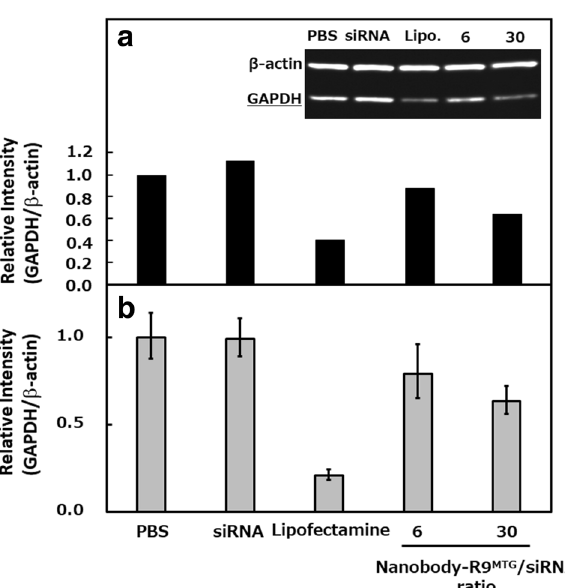
Figure 7. RNAi by Nanobody-R9 MTG –siRNA. ( a ) Western blot analysis of GAPDH in the A431 cell extract mixed with Nanobody-R9 MTG – siRNA using anti-GAPDH monoclonal antibody. ( b ) Real time PCR of the transcript in A431 cell extract mixed with Nanobody-R9 MTG – siRNA. Lipofectamine was used as a positive control. PBS phosphate buffered saline, Lipo lipofectamine, 6 and 30 indicate the Nanobody-R9 MTG /siRNA ratio. T-test showed less than 0.05 for all combinations except between PBS and siRNA (T-test < 0.54). Full-length gel image for ( a ) provided in Supplementary Fig.